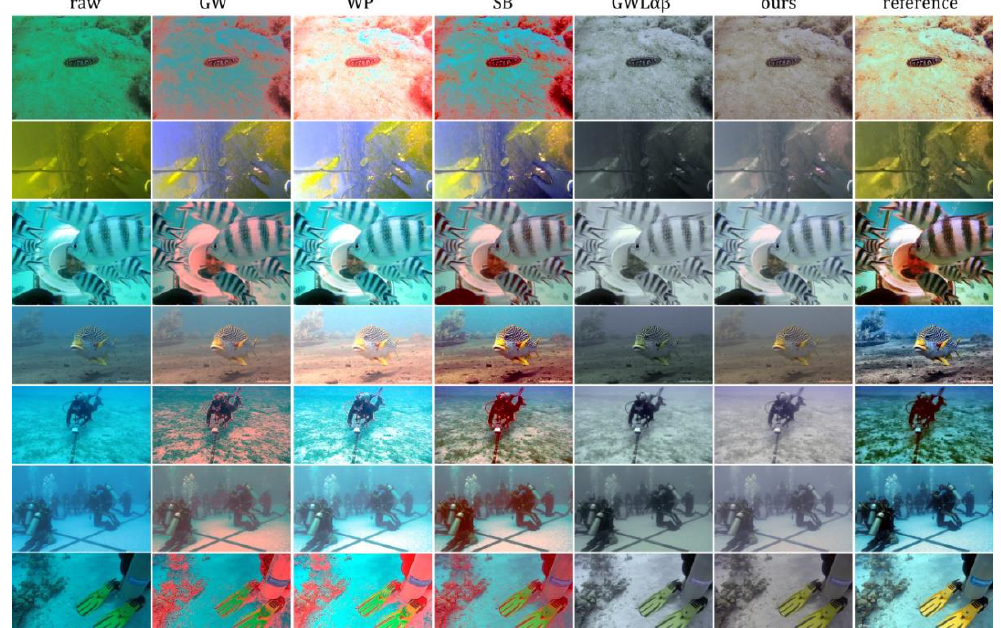
Figure 10. Sample images on which the proposed method produces more natural results than reference images. From left to right are raw underwater images, the results of gray-world (GW) method, white-patch (WP) method, statistical-based (SB) method [21], Bianco’s (GWLαβ) method [37], proposed method and reference images.